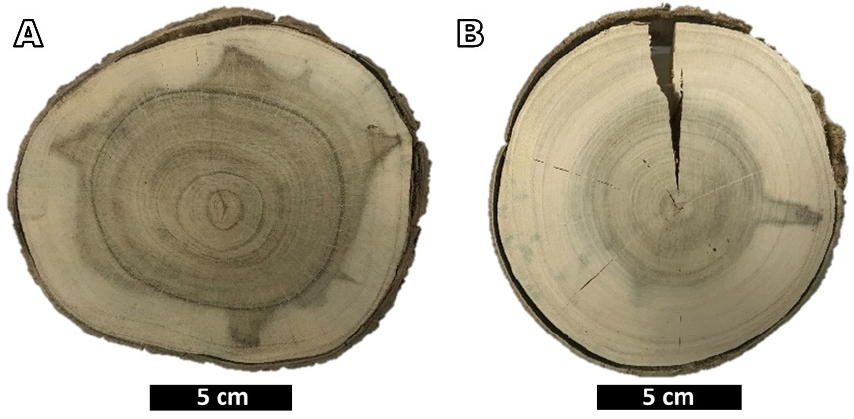
Figure 2. Wood discs of Acacia mangium ( A ) and Acacia hybrid ( B ).